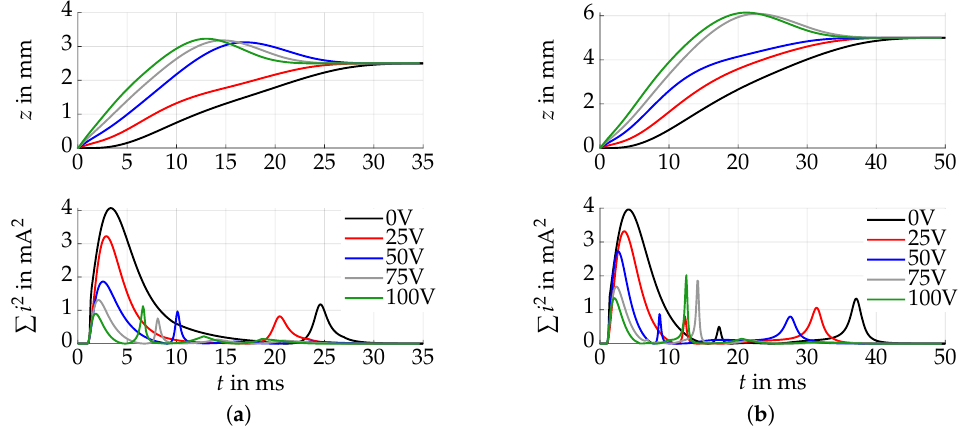
Figure 7. Combined kick and catch trajectories to both equilibria for different piezoelectric kick voltages between 0V and 100V. Top panel: position z of the proof mass. Bottom panel: the respective sum of squared electrical currents. ( a ) The kick to the equilibrium at 2.5mm is shown. ( b ) A similar effect is achieved for the kick to the equilibrium at 5mm. In both cases, the electrical currents are reduced with increasing kick